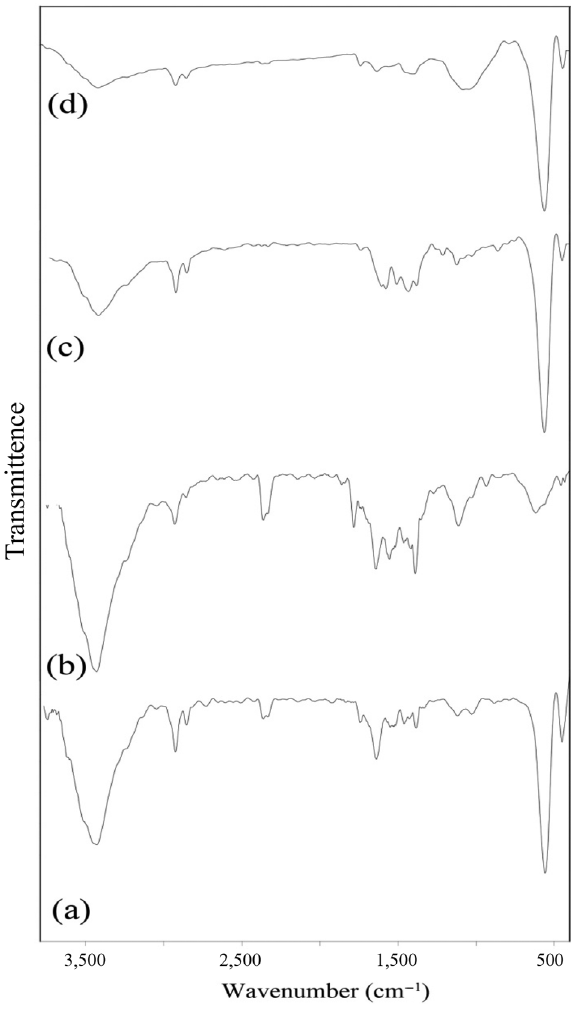
Figure 3: FTIR spectra of BiFeO 3 powder prepared by: (a) PVP, (b) PEG, (c) Pechini and (d)